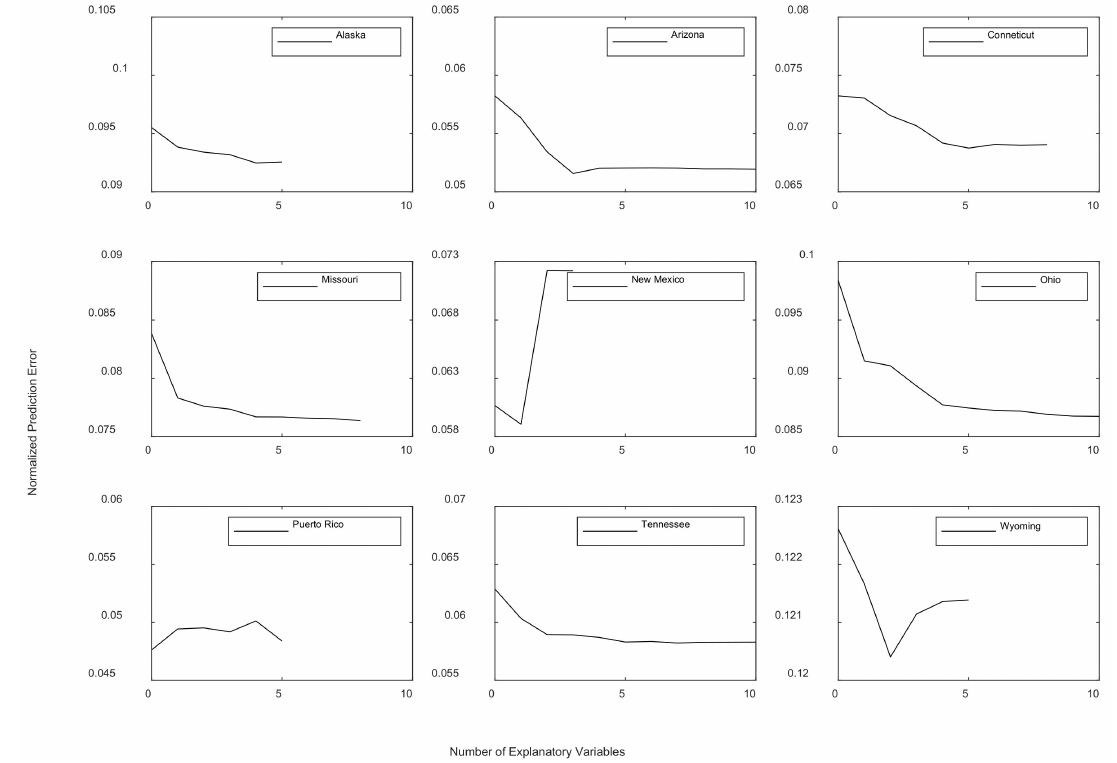
Figure 7. Normalized prediction error depending on the number of explanatory variables for the deck elements in randomly selected states.